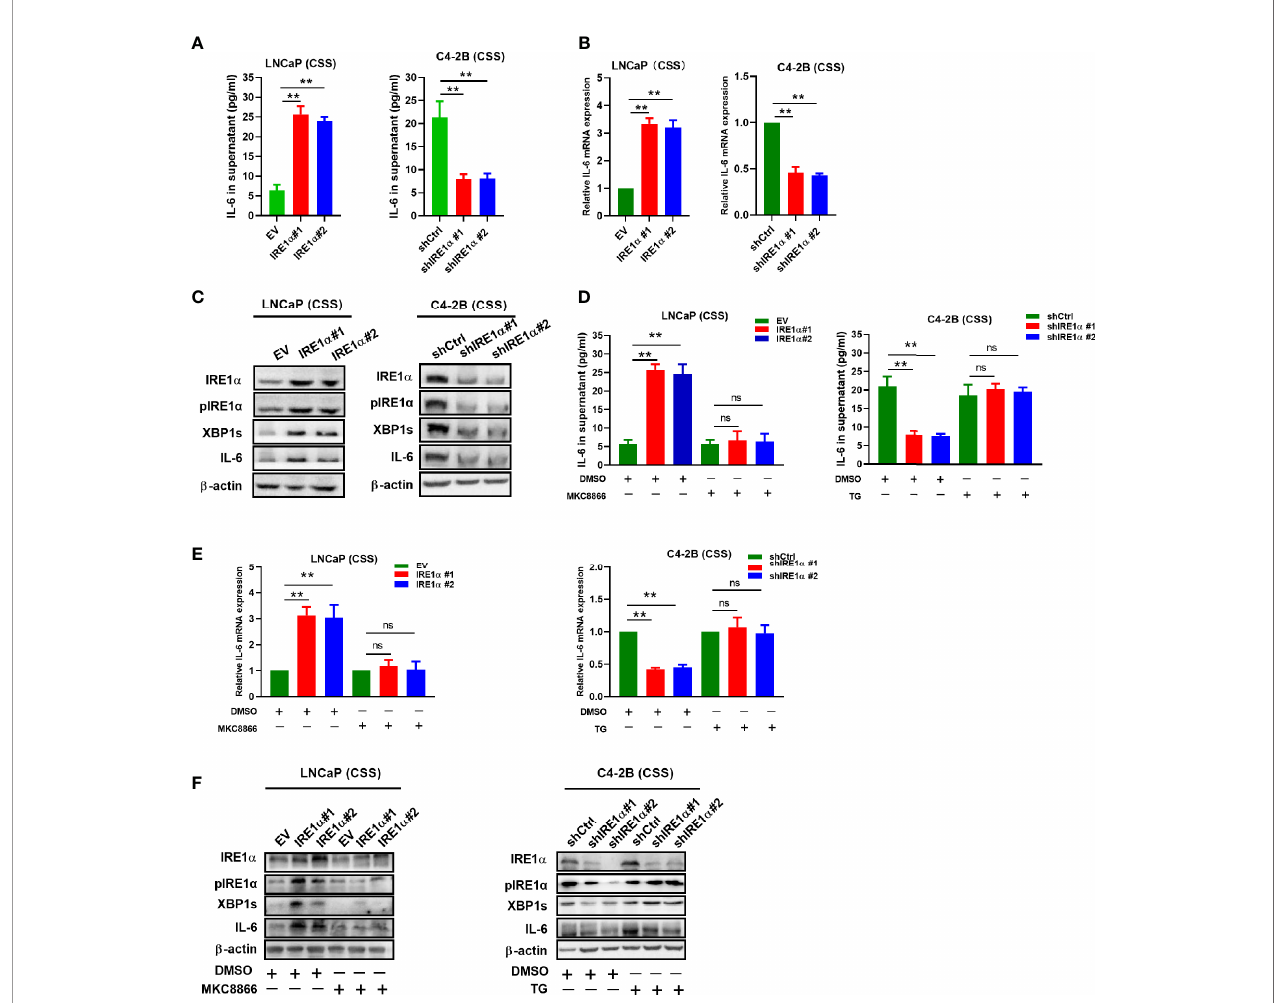
FIGURE 4 | IRE1 a stimulates IL-6 production via the IRE1 a /XBP-1s pathway in prostate cancer cells. (A) LNCaP cells with IRE1 a overexpression or C4-2B cells with IRE1 a knockdown were cultured in an androgen deprivation medium with CSS for 48 h, and mRNA levels of IL-6 were determined by qPCR. (B, C) ELISA and western blot analysis for the protein expression of IL-6 in LNCaP cells with IRE1 a overexpression or C4-2B cells with IRE1 a knockdown. (D – F) MKC8866 and thapsigargin (TG), the inhibitor and the agonist of the IRE1 a /XBP-1s pathway, were used to detect the effect of the IRE1 a /XBP-1s pathway on IL-6 expression. Data shown are the mean ± SD from three independent experiments, **P < 0.01. ns, no signi fi